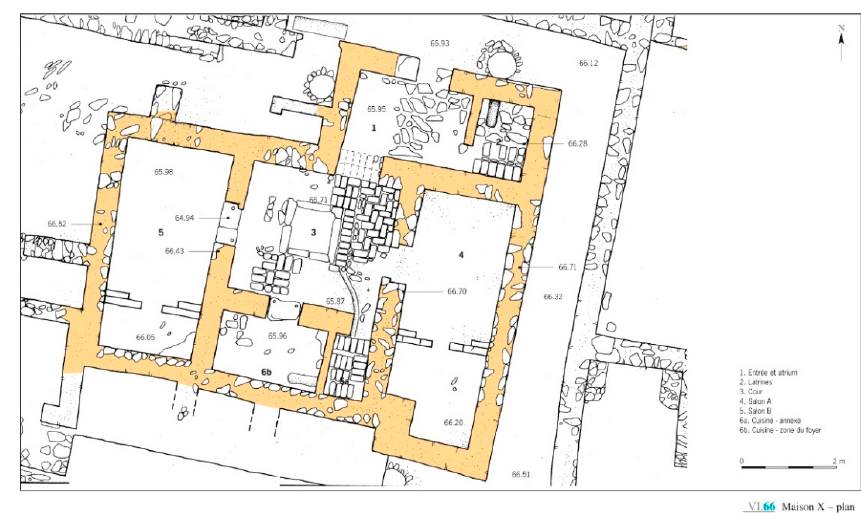
Figure 5. M é rtola—house n. 10 (plan). Plan by the author. Figure 5. Mértola—house n. 10 (plan). Plan by the author. Figure 5. Mértola—house n. 10 (plan). Plan by the author.